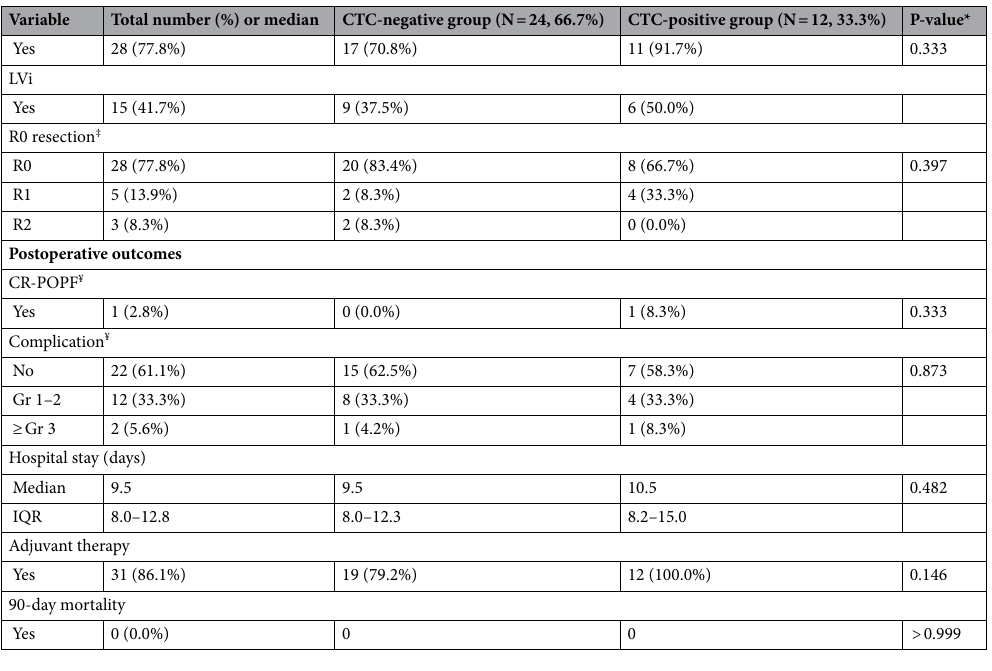
Table 1. Clinico-pathological characteristics according to the detection of circulating tumour cells. ASA classification American Society of Anesthesiologists physical status classification, BMI body mass index, CA 19-9 Carbohydrate antigen 19-9, CTCs circulating tumour cells, PD pancreaticoduodenectomy, DP distal pancreatectomy, AJCC American Joint Committee on Cancer, PNi perineural invasion, LVi lymphovascular invasion, CR-POPF clinical-related postoperative pancreatic fistula, IQR interquartile range, NA not applicable. *The p-values were calculated using the Student t-test or Mann–Whitney U test for continuous variables and the χ 2 test or Fisher exact test for binary variables between the CTC-negative and CTC-positive groups. † The T, N, and M stages were defined based on the American Joint Committee on Cancer (AJCC) 8th edition. ‡ R0 and R1 were defined as a distance of < 1 mm and ≥ 1 mm from the tumour to the resection margin, respectively. R2 was defined as the presence of residual extrapancreatic metastatic disease and localized disease that was resected with a grossly positive margin. ¥ Postoperative pancreatic fistula (POPF) and overall complications were assessed and graded on the basis of the criteria of the International Study Group of Pancreatic Fistula and the Clavien–Dindo complication classification,